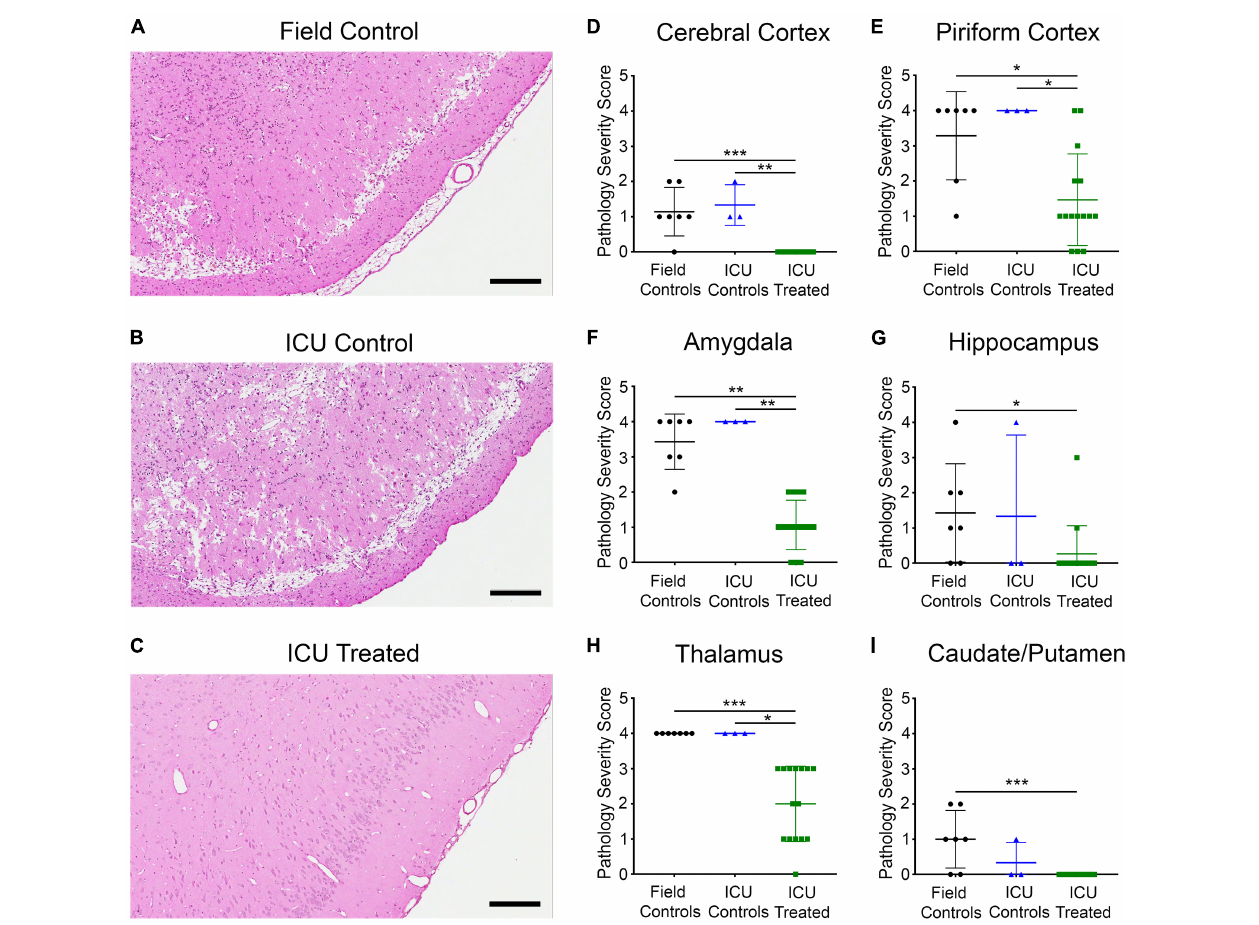
FIGURE 6 | Representative images of H&E staining in the piriform cortex of rats from each treatment group (A–C) , and pathology severity scores in six brain regions (D–I) . Marked neuronal necrosis and parenchymal loss were evident for both (A) the field control rat and (B) the ICU control rat, while (C) the ICU-treated rat appeared relatively unaffected in the same region. Scale bars for panel (A–C) represent 200 µ m. Proportion of neurons exhibiting damage in each region from individual field controls ( n = 7), ICU controls ( n = 3), and ICU-treated rats ( n = 15) was scored by a board-certified pathologist according to the following scale: 0 = No lesion; 1 = Minimal (1–10%); 2 = Mild (11–25%); 3 = Moderate (26–45%); and 4 = Severe ( > 45%). Regions examined included (D) cerebral cortex, (E) piriform cortex, (F) amygdala, (G) hippocampus, (H) thalamus, and (I) caudate putamen. Within each region, scores for each treatment group were compared using Kruskal–Wallis tests with Dunn’s multiple comparison. Significant pairwise differences are indicated as follows: * p < 0.05, ** p < 0.01, *** p < 0.001. For panels (D–I) , lines show mean values for each treatment group, and error bars show standard